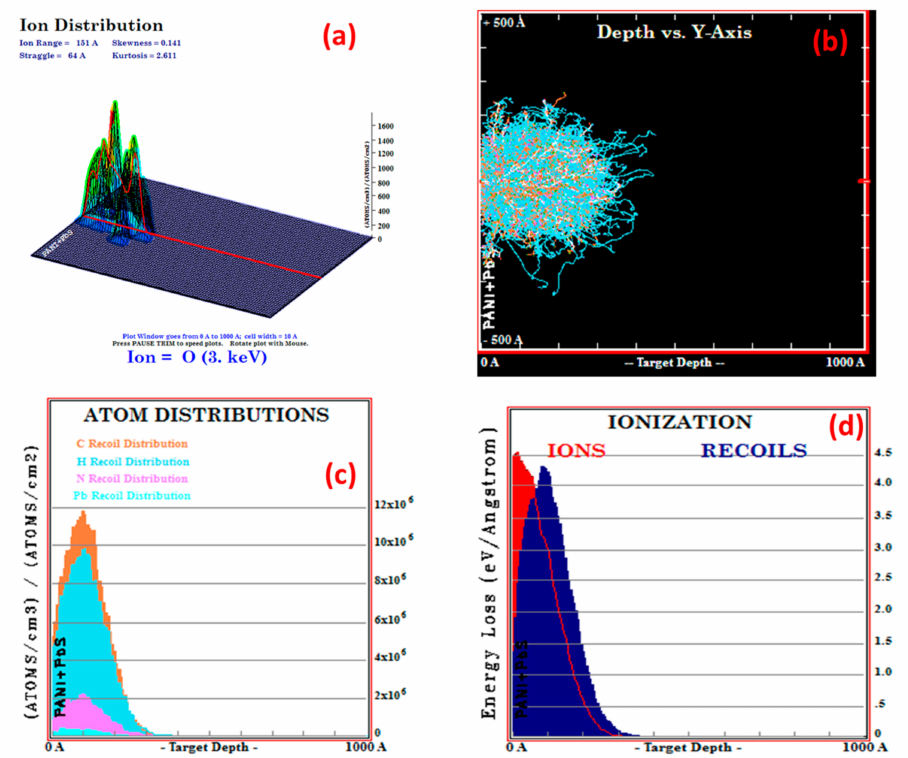
Figure 1. ( a ) Ion range of oxygen beam with PANI/PbS, ( b ) distribution of oxygen ions with PANI/PbS, ( c ) target vacancies influenced by collided oxygen ions, and ( d ) ionization of collided oxygen ions as well as recoil